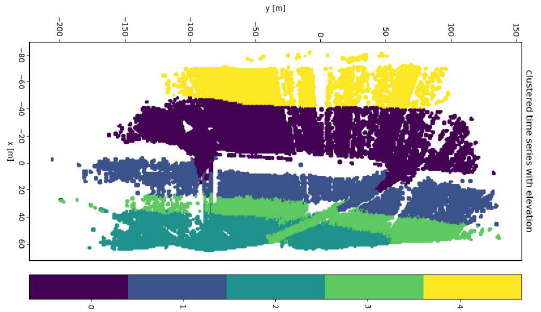
Figure 6. Clusters resulting from including original elevations in time series are dominated by